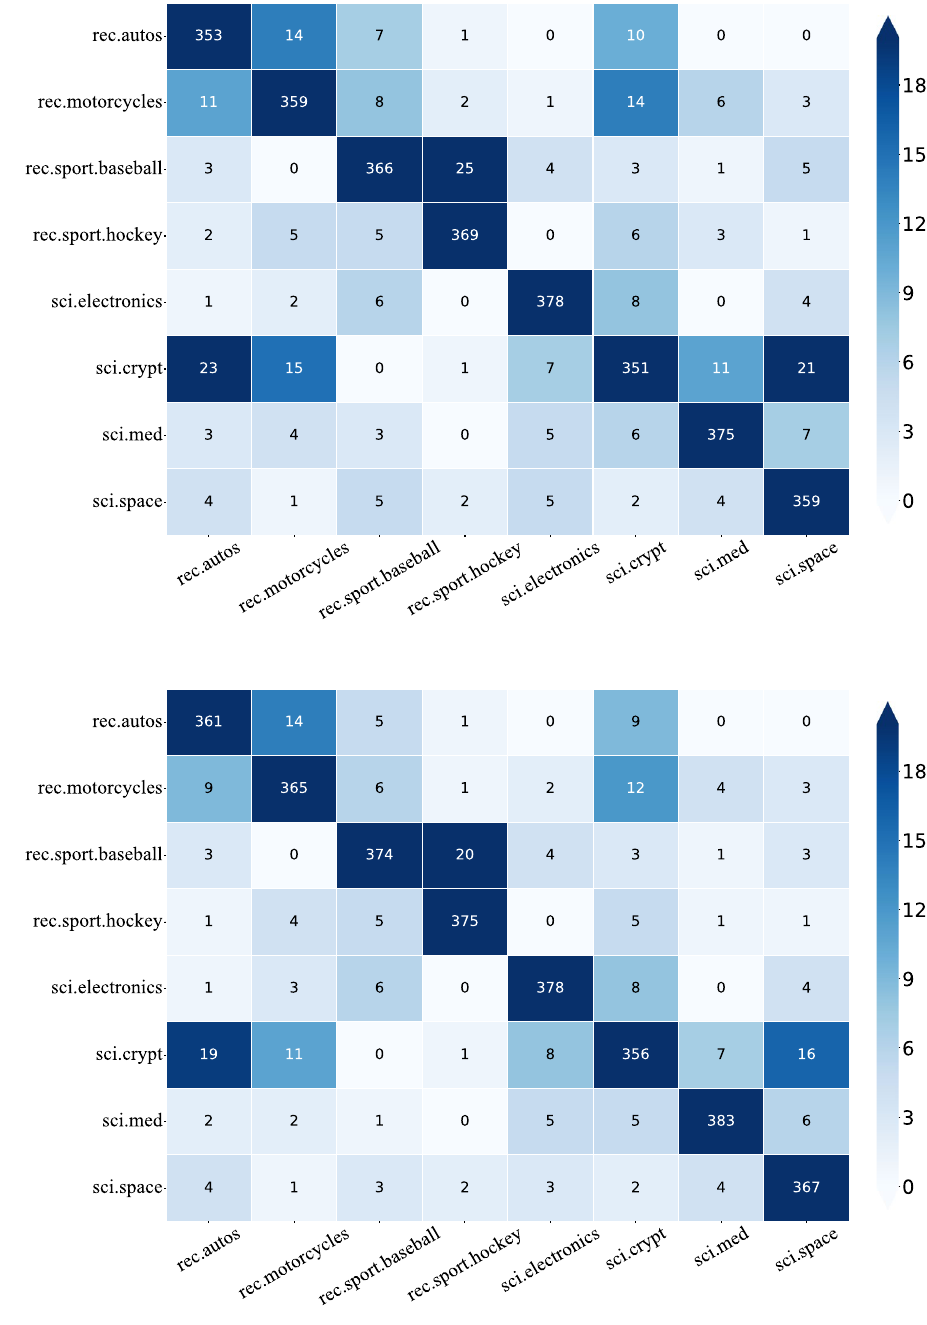
Fig. 15 Testing with multi-loss